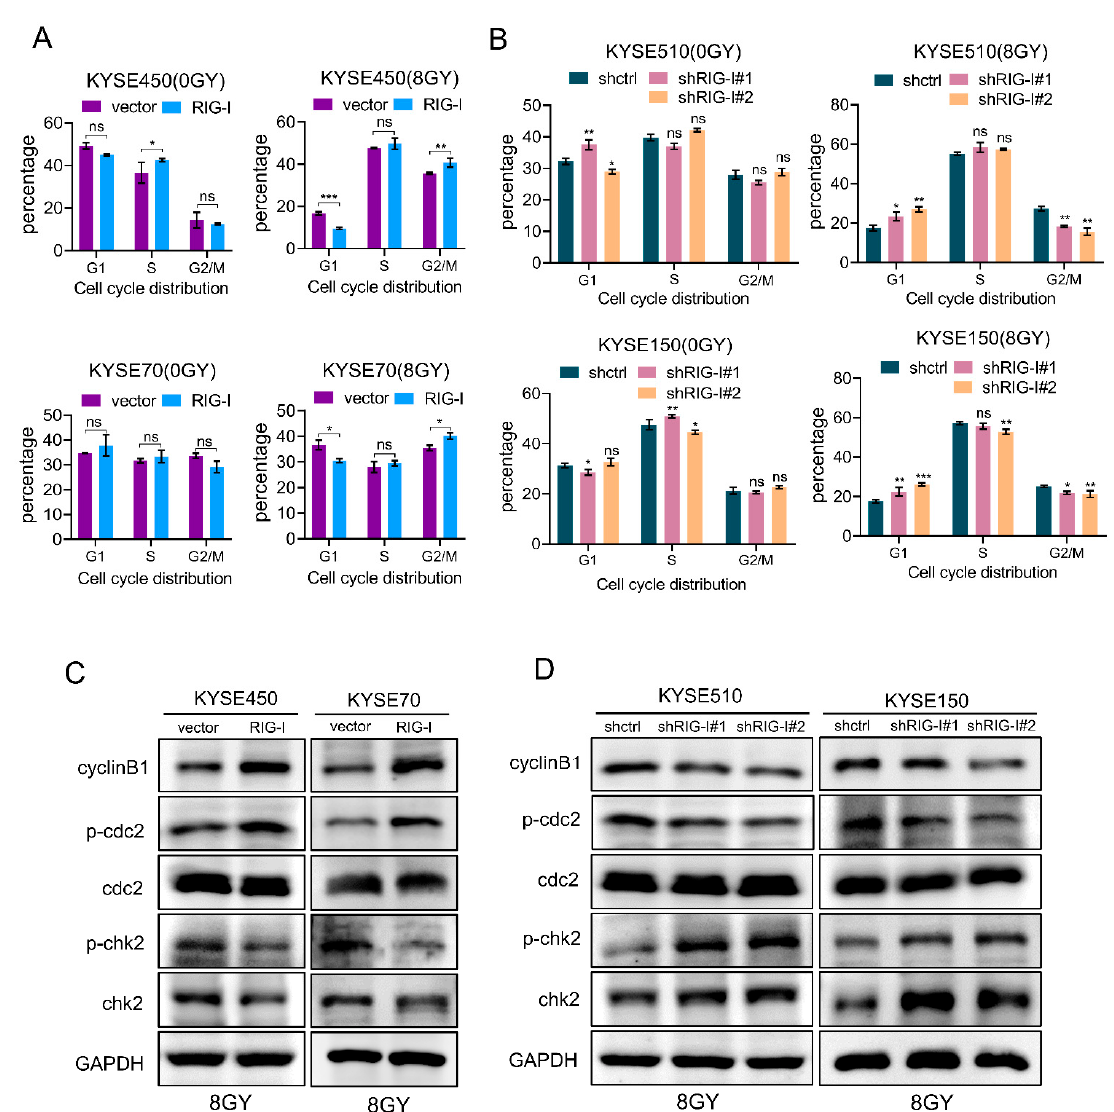
Figure 5. RIG-I causes radiation-induced G2/M phase arrest. ( A ) Cell cycle distribution upon overexpression of RIG-I in KYSE70 and KYSE450 cells with or without irradiation was assessed using flow cytometry. Empty vector was used as a control. ( B ) Cell cycle distribution upon knockdown of RIG-I in KYSE150 and KYSE510 cells with or without irradiation was assessed using flow cytometry. shRNA-control was used as a control. ( C , D ) G2/M phase DNA damage checkpoint signaling pathway-related proteins (detected using Western blotting) in RIG-I-overexpressing KYSE70 and KYSE450 cells and RIG-I-lacking KYSE150 and KYSE510 cells. Empty vector and shRNA-control were used as controls. GAPDH was used as an internal control. Data are shown as mean ± SD from three independent experiments. * p < 0.05, ** p < 0.01, and *** p < 0.001.